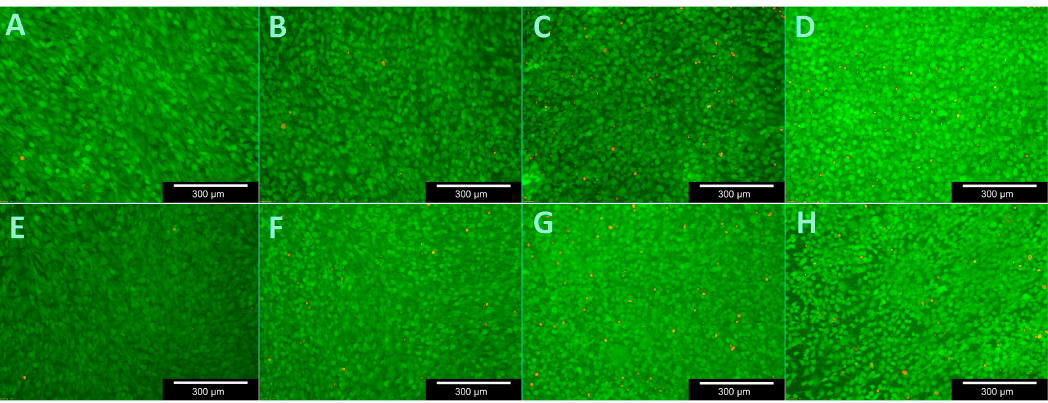
Figure 7. Viability assay with MG 63 for 21 days. ( A – D ): samples (days 3, 7, 14 and 21); ( E – H ): controls (days 3, 7, 14 and 21).